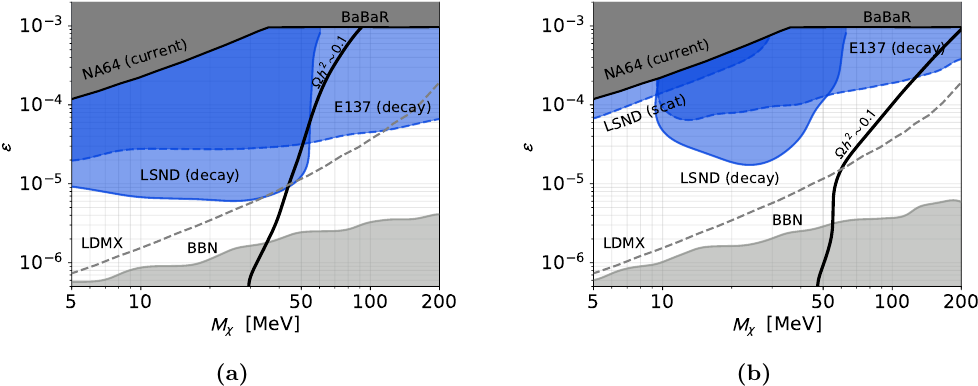
Figure 8. Bounds for the secluded regime from the E137 [30], LSND [77] arising from DM scattering and (cid:31) 2 decay (blue regions) and missing energy searches (dark grey regions and grey dashed line for the LDMX projection from [5]). The light grey region at the bottom of the plot are excluded by BBN constraints [6]. The thick black lines correspond to points featuring the correct relic density of DM. We varied M (cid:31) and " using (cid:11) D = 0 : 8 10 (cid:0) 3 ( g V = 0 : 1) and (a) M S : M (cid:31) : M V : (cid:1) (cid:31) = 5 (cid:2) or (b) M S : M (cid:31) : M V : (cid:1) (cid:31) = 9 : 1 : 3 : 0 : 1. The e(cid:11)ective Yukawa coupling between DM of the 10 dark Higgs boson is (cid:12)xed at 0 :